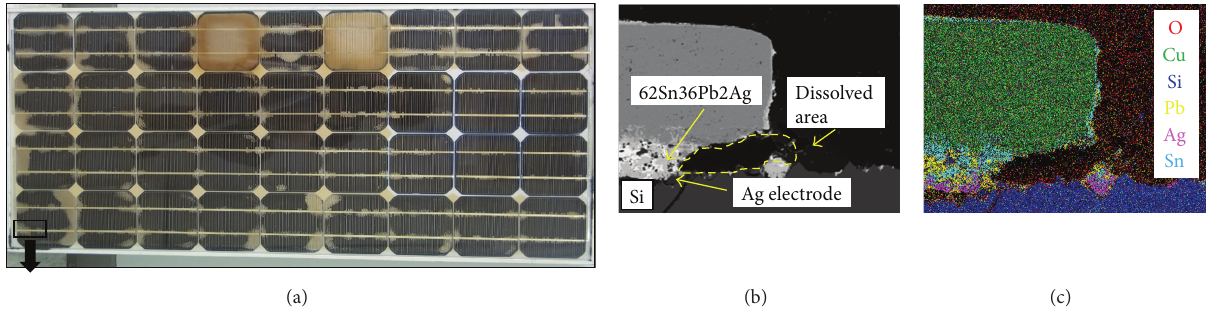
Figure 1: Cross-sectional SEM micrographs: (a) 25-year-aged PV module, (b) cross-sectional image at the solder interconnection, and (c) energy-dispersive X-ray (EDX) mapping